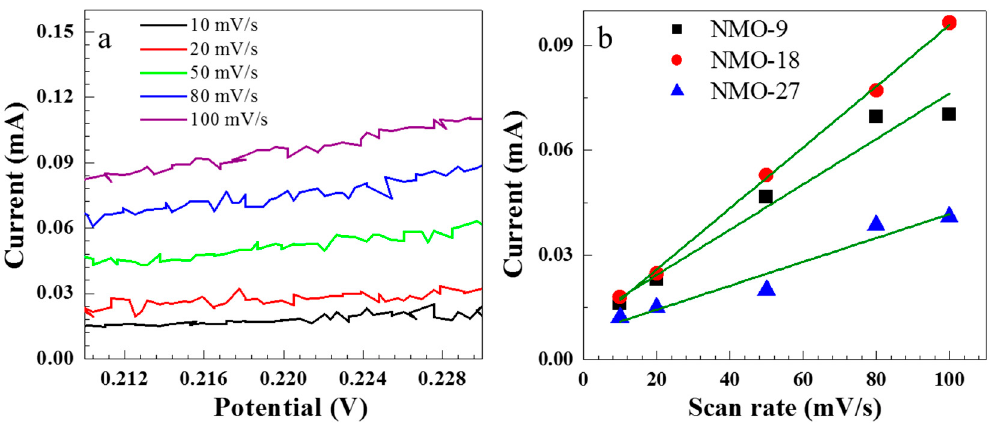
Figure 4. ( a ) Cyclic voltammograms (CV) for NMO-18 at various scan rates in the non-Faradic voltage region (0.21–0.23 V); ( b ) The measured current at 0.22 V as a function of the scan rate for NMO-9, NMO-18, and NMO-27.